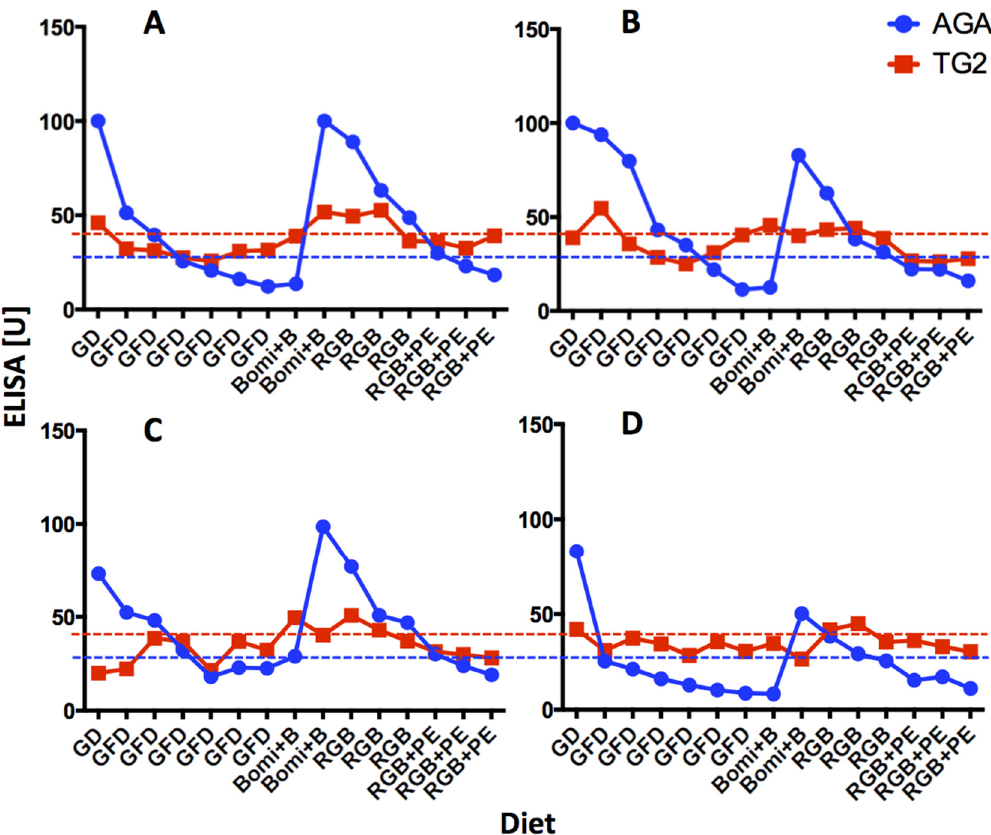
Figure 1. Anti-gliadin antibodies (AGA) and anti-intestinal tissue transglutaminase (TG2) plasma antibodies in four gluten-sensitive (GS) rhesus macaques ( A – D ). Gluten-modified diets (GD, GFD, Bomi + B, RGB and RGB + PE) that were used to feed the macaques are indicated. Individual time points represent two-week intervals. Blue dashed line represents AGA baseline, i.e., 25 ELISA units while red dashed line represents TG2 antibody baseline, i.e., 40 units. Values elevated above these lines were significantly greater ( p < 0.05) than values generated with plasmas from healthy, normal macaques.